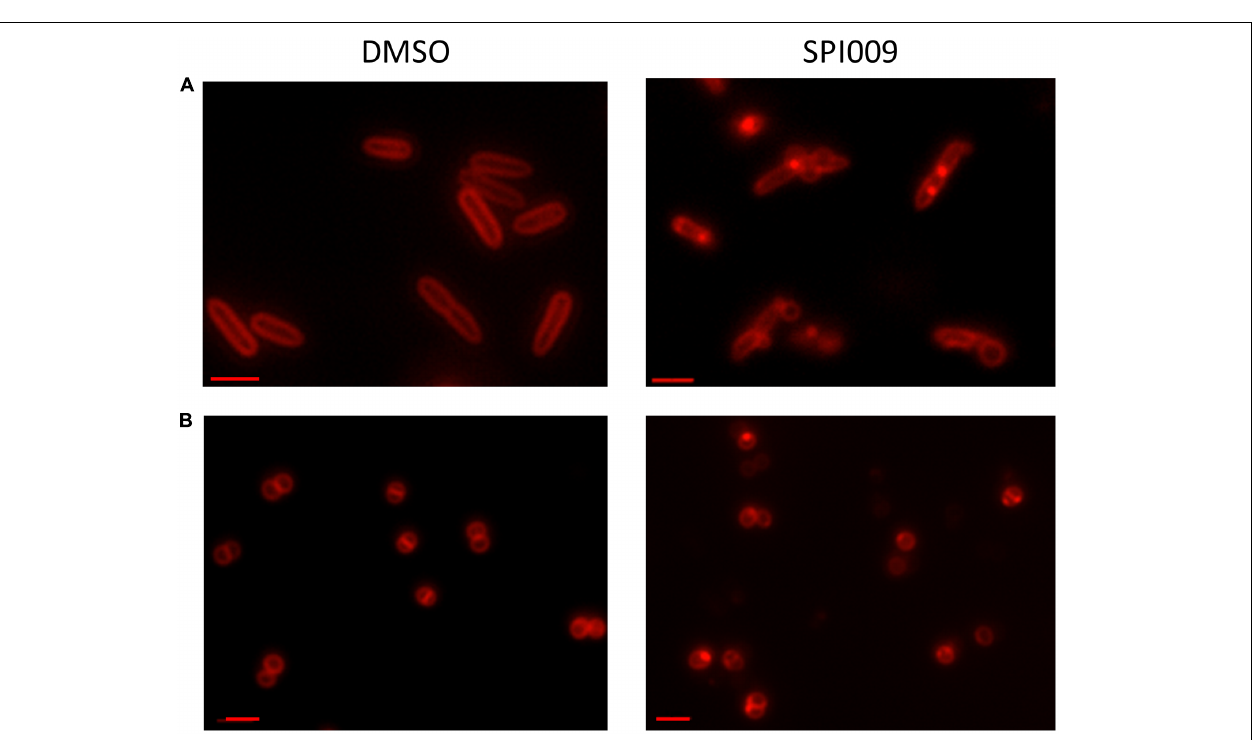
FIGURE 5 | SPI009 extensively permeabilizes both inner and outer membrane of P. aeruginosa. (A) Effect of increasing concentrations of SPI009 on the inner membrane permeability, as measured by the SYTOX Green uptake assay. Cells were treated for 30 min using melittin (Mel; 1 × MIC) as a positive control. (B) Outer membrane permeability after treatment with increasing concentrations of SPI009, using polymyxin B (PMB, 1 × MIC) as a positive control. Data for both assays represent the mean of at least three independent repeats ± SEM. Statistical comparisons with the untreated control were performed using a one-way ANOVA ( α = 0.05) with Dunnett’s correction for multiple comparison ( ∗ P < 0.05, ∗∗ P < 0.01, ∗∗∗∗ P < 0.0001).